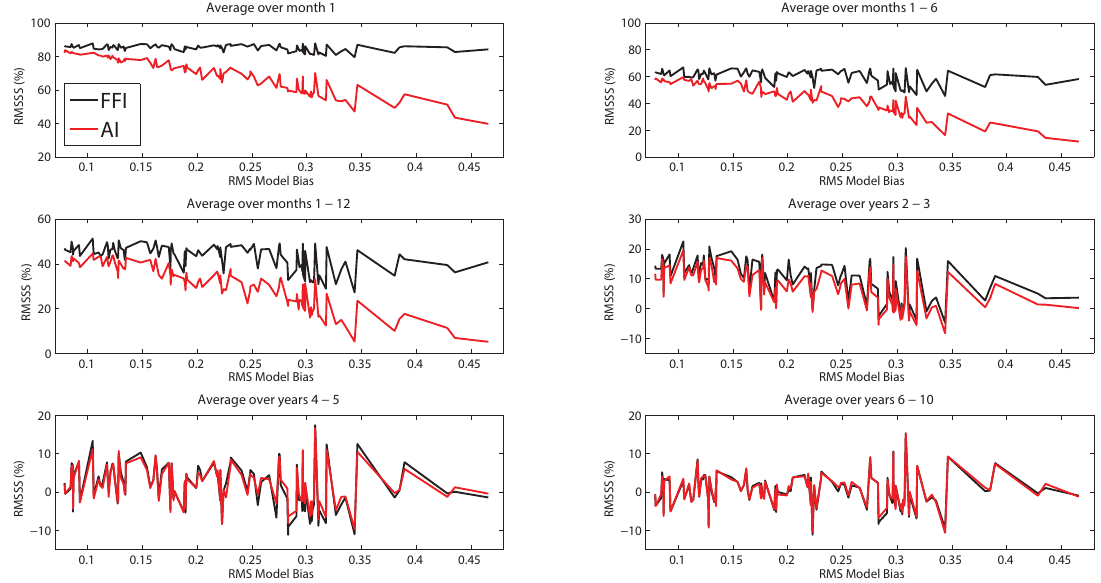
Fig. 5. RMSSS as a function of the RMS model bias. The six panels refer to six different averaging periods and are indicated in the corresponding labels. FFI (black line), AI (red